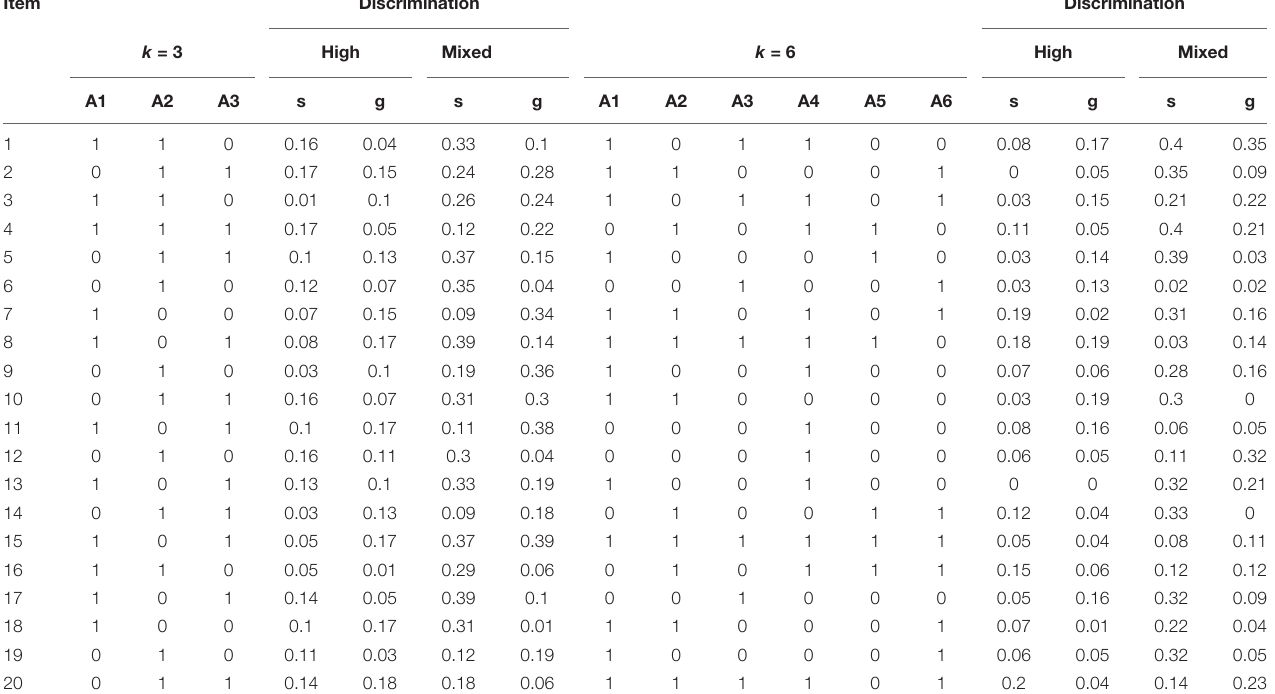
TABLE 1 | Q matrices and item parameters used in the simulation (20 items). Item Discrimination